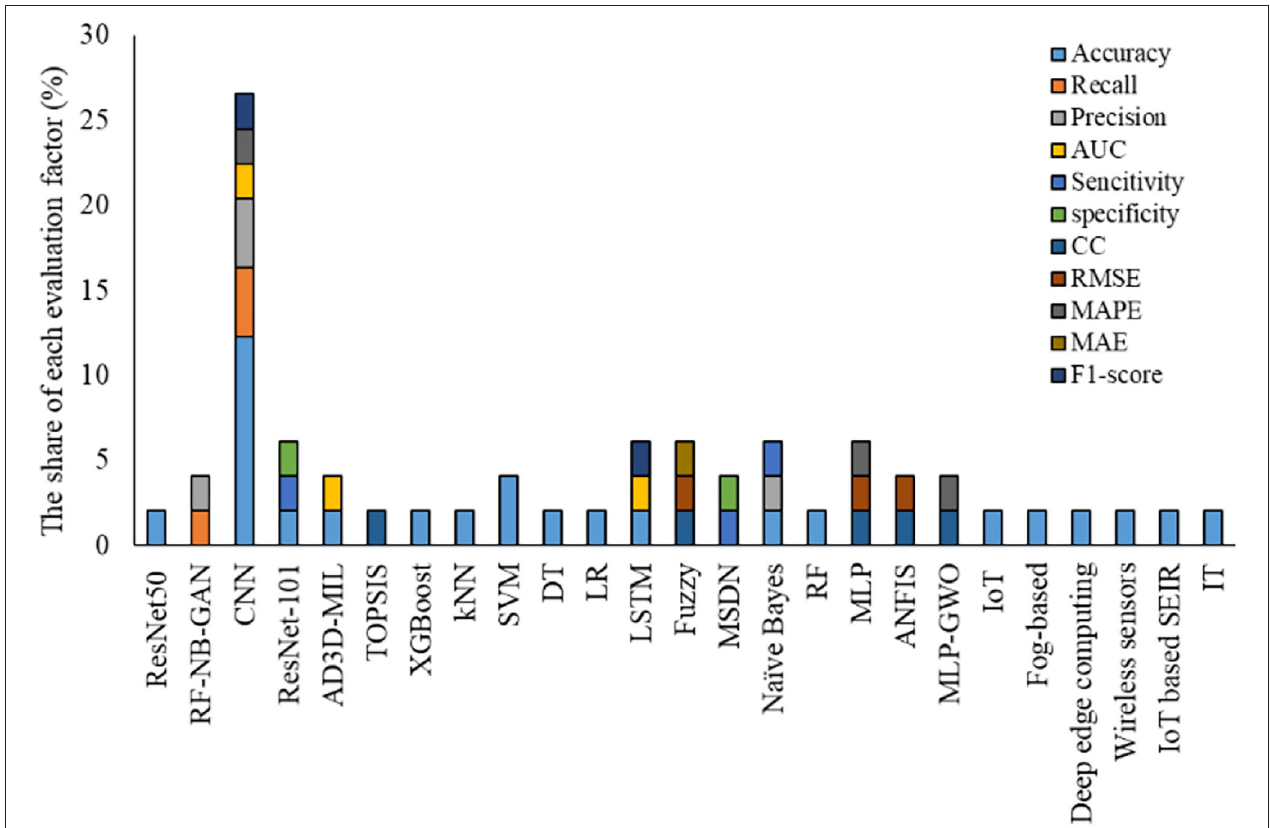
FIGURE 8 | The share of each evaluation factor (%) for analyzing